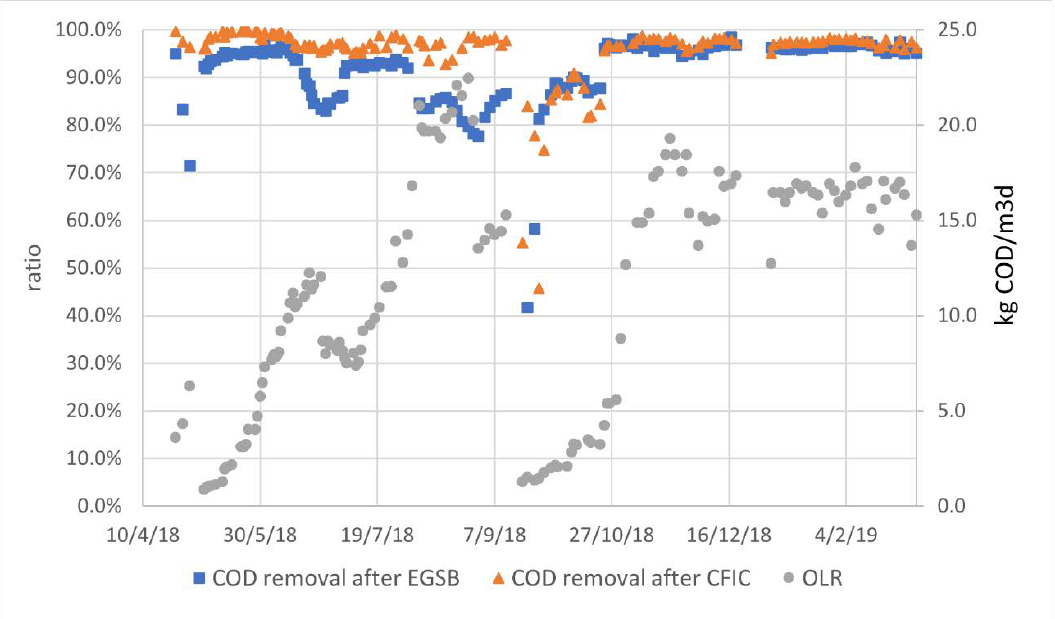
Figure 8. Organic loading rate and sCOD removal efficiency of the HyVAB operation.